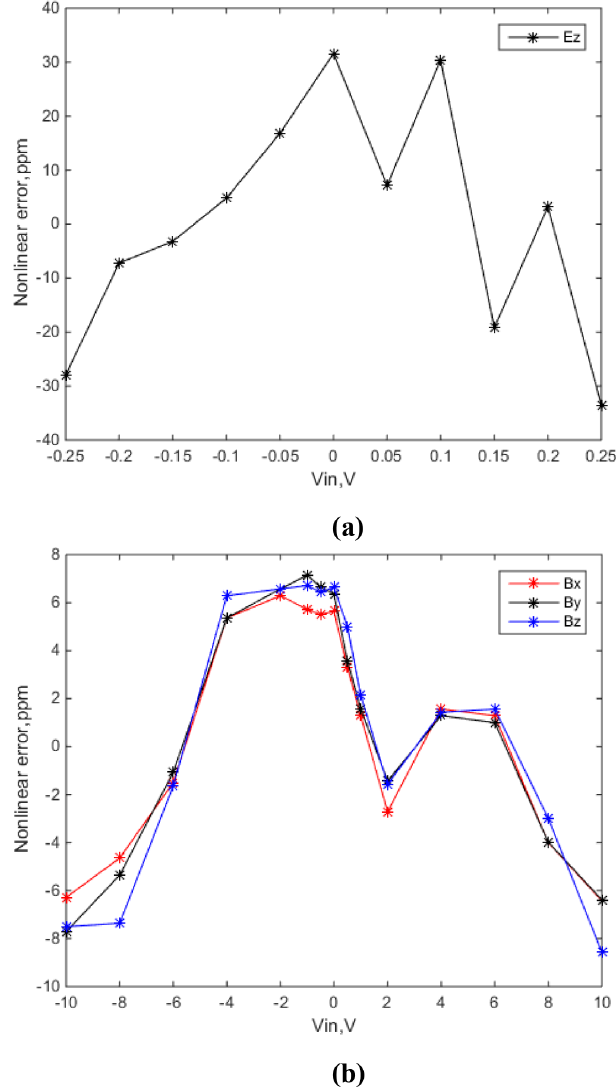
Figure 8. Nonlinear errors of channel fitting straight line and the standard voltage curve. (a) Electrical component. (b) Magnetic